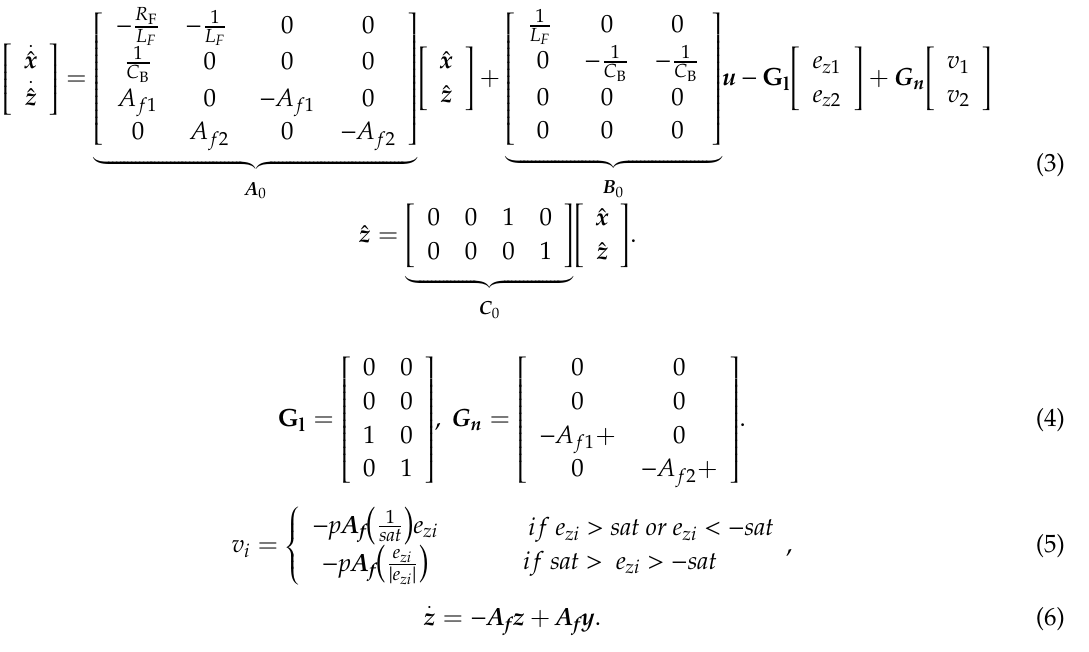
( d ) Figure 6. Fault reconstructions for a sensor fault-free scenario with a catenary voltage drop. ( a ) Motor torque. ( b ) Catenary voltage. ( c ) Catenary current sensor fault reconstruction. ( d ) DC-link voltage sensor fault reconstruction.